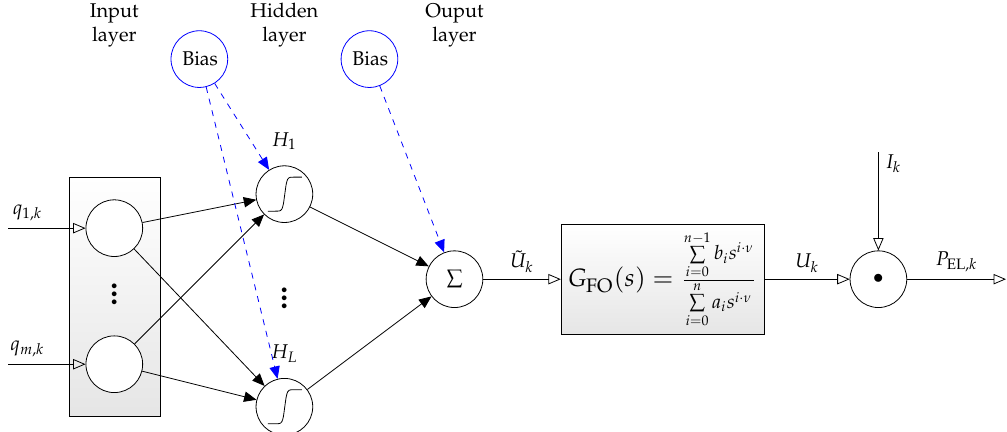
Figure 9. Hammerstein-type dynamic model for the electric power characteristic of the SOFC stack with fractional-order dynamics with the network inputs ϑ m, ( 1,1,1 ) , k , ϑ m, ( 1,3,1 ) , k , I k , ϑ CG,m, k , ˙ m N